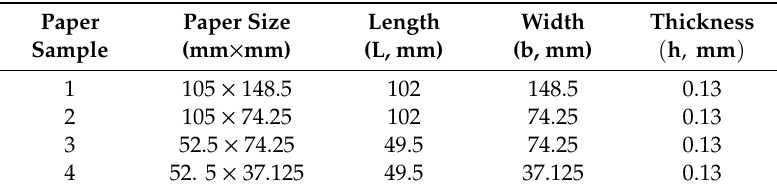
Table 2. Parameters of paper samples.